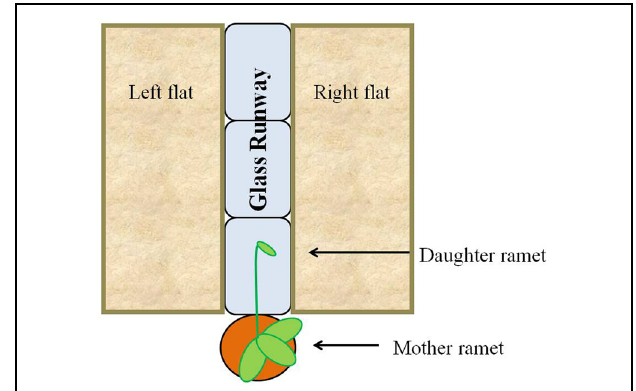
FIGURE 3 | Experimental scheme. Strawberry daughter ramets were allowed to grow over a glass runway flanked with non-sterilized (live) or sand/sterilized (dead) substrates. Distribution of live and dead substrate on the left or right side of the plant was